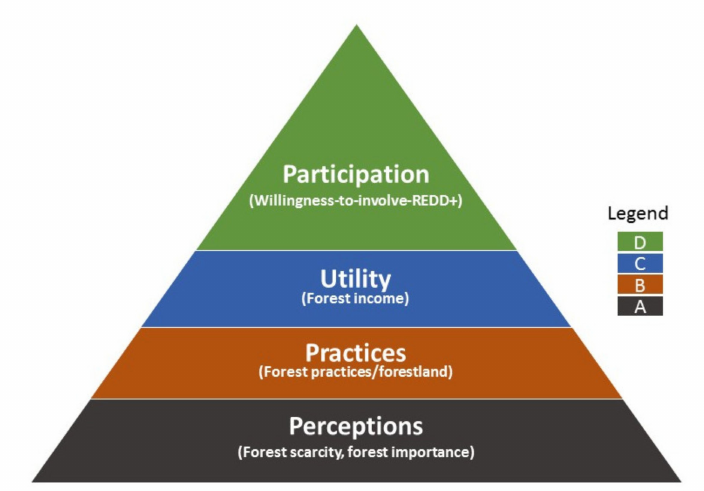
Figure 1. Conceptual framework of forest